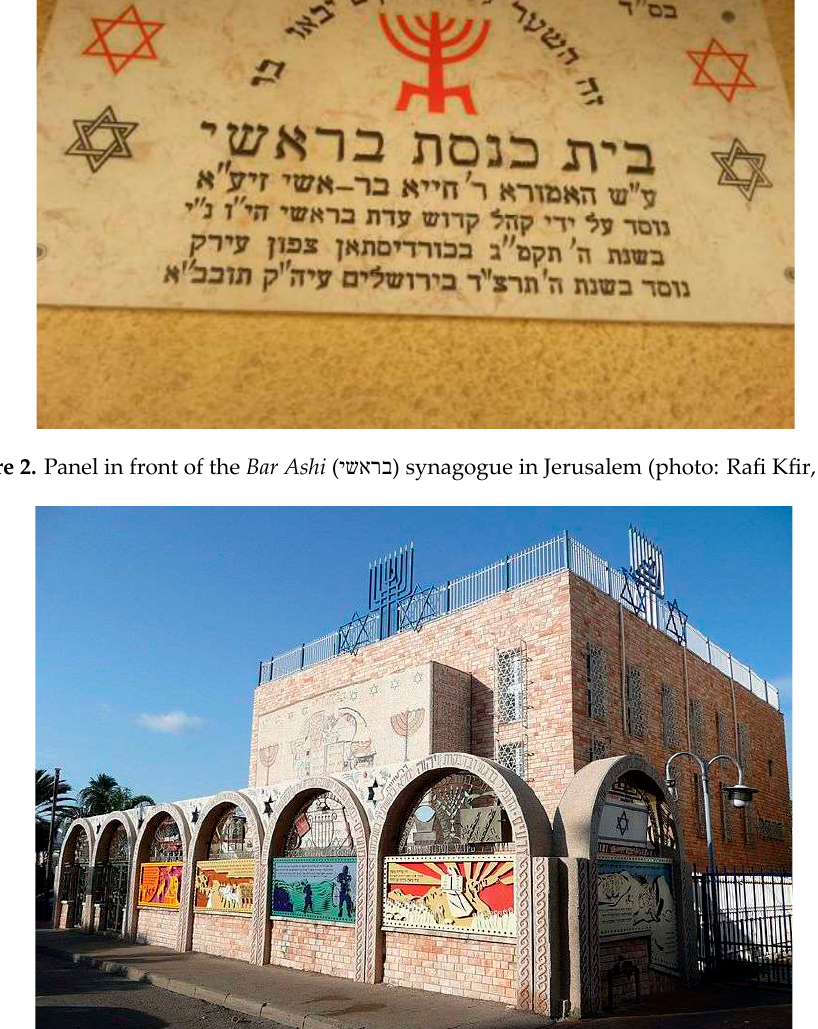
Figure 3. Exterior of the Or Torah Synagogue, Acre (Wikipedia, Ark Vol, 2011).